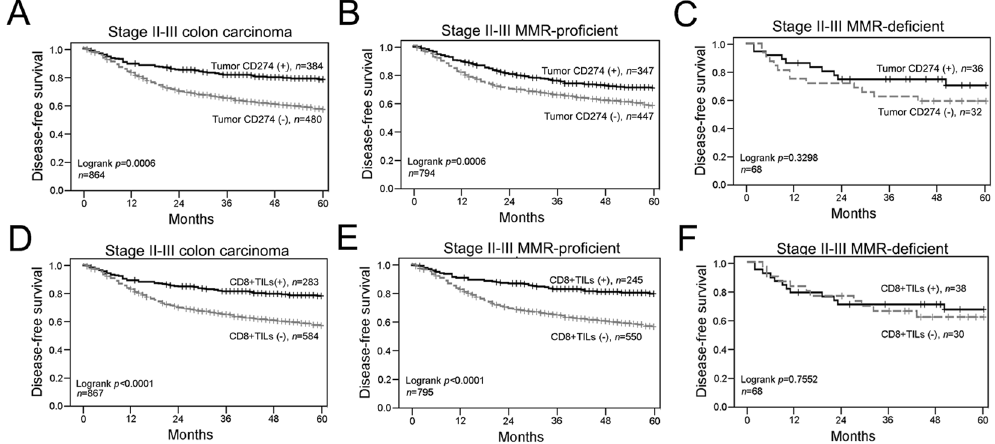
Figure 3. The association of CD8 + TILs and tumor CD274 level in disease-free survival (DFS) among stage II-III colon carcinoma. ( A ) Stage II-III colon carcinoma patients with high tumor CD274 level within the tumor microenvironment had better 5-year DFS (n = 864, p = 0.0006). ( B ) High tumor CD274 level in stage II-III MMR-proficient colon carcinoma patients within the tumor microenvironment had improved 5-year DFS (n = 794, p = 0.0006). ( C ) In stage II-III MMR-deficient colon carcinoma patients, patients with high tumor CD274 level have no association with 5-year DFS (n = 68, p = 0.3298). ( D ) Stage II-III colon carcinoma patients with high density of CD8 + TILs had better 5-year DFS (n = 867, p < 0.0001). ( E ) High density of CD8 + TILs in stage II-III MMR-proficient colon carcinoma patients within the tumor microenvironment had improved 5-year DFS (n = 795, p < 0.0001). ( F ) In stage II-III MMR-deficient colon carcinoma patients, patients with high CD8 + TILs have no association with 5-year DFS (n = 68, p = 0.7552).